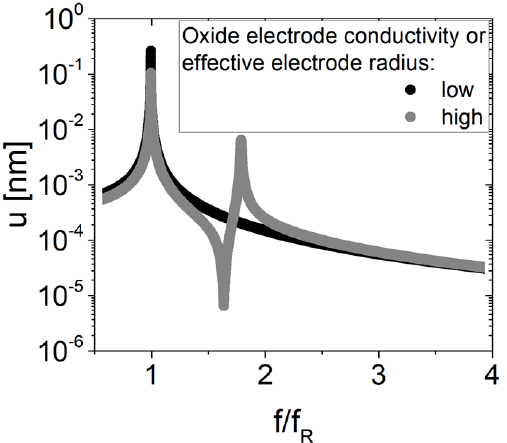
Figure 12. Mechanical impedance spectra for a TSM resonator operated with an additional oxide electrode for low (black, f R = 4910928Hz) and high (grey, f R = 4909035Hz) oxide electrode conductivity. The oxide electrode conductivity is representative of the effective electrode